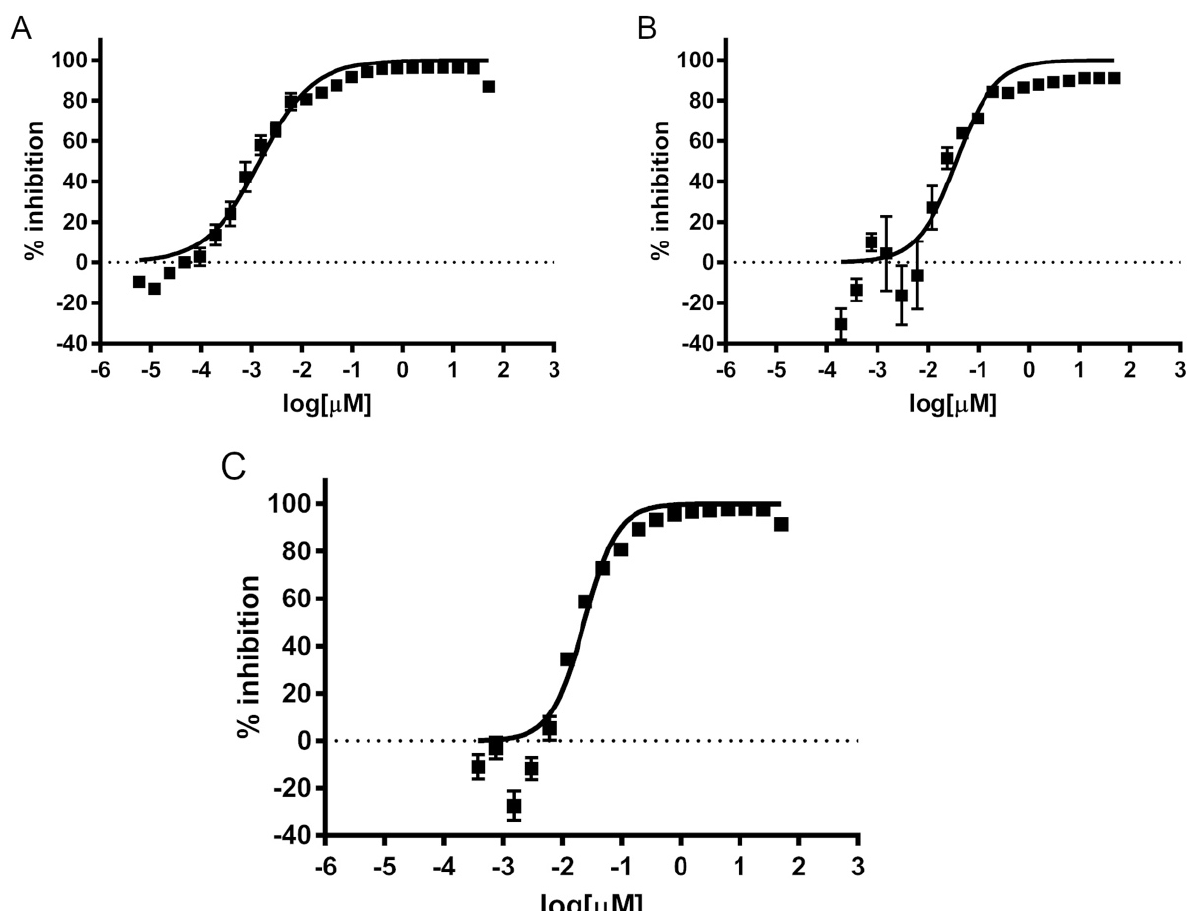
Figure 1. Concentration—dependent inhibition of growth of Acanthamoeba trophozoites by isavuconazonium sulfate. Different concentrations of isavuconazonium were tested in triplicate for activity against trophozoites of Acanthamoeba T4 strains. The data points represent mean percentage growth inhibition of ( A ) Ma strain, ( B ) CDC:V240, and ( C ) MEEI 0184 of different concentrations of isavuconazonium. EC 50 curves were generated from mean values of percentage growth inhibition of isavuconazonium against Acanthamoeba.